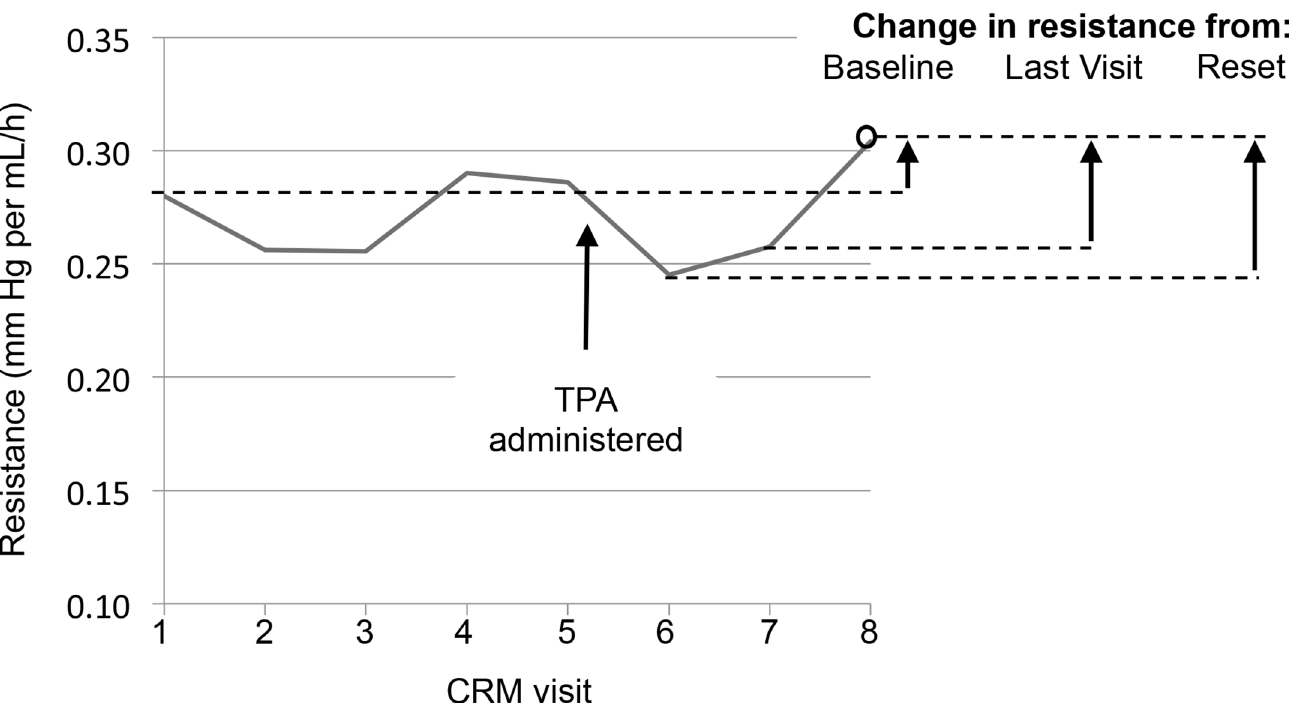
Fig 4. Metrics used to report change in resistance. Change in resistance at each visit was described as the proportional change in estimated resistance within each lumen compared to that at Baseline (i.e., enrollment or first CRM visit), Reset (i.e., first CRM visit after TPA administration), or Last Visit (i.e., immediately previous CRM visit). Figure shows data from a single study participant and catheter